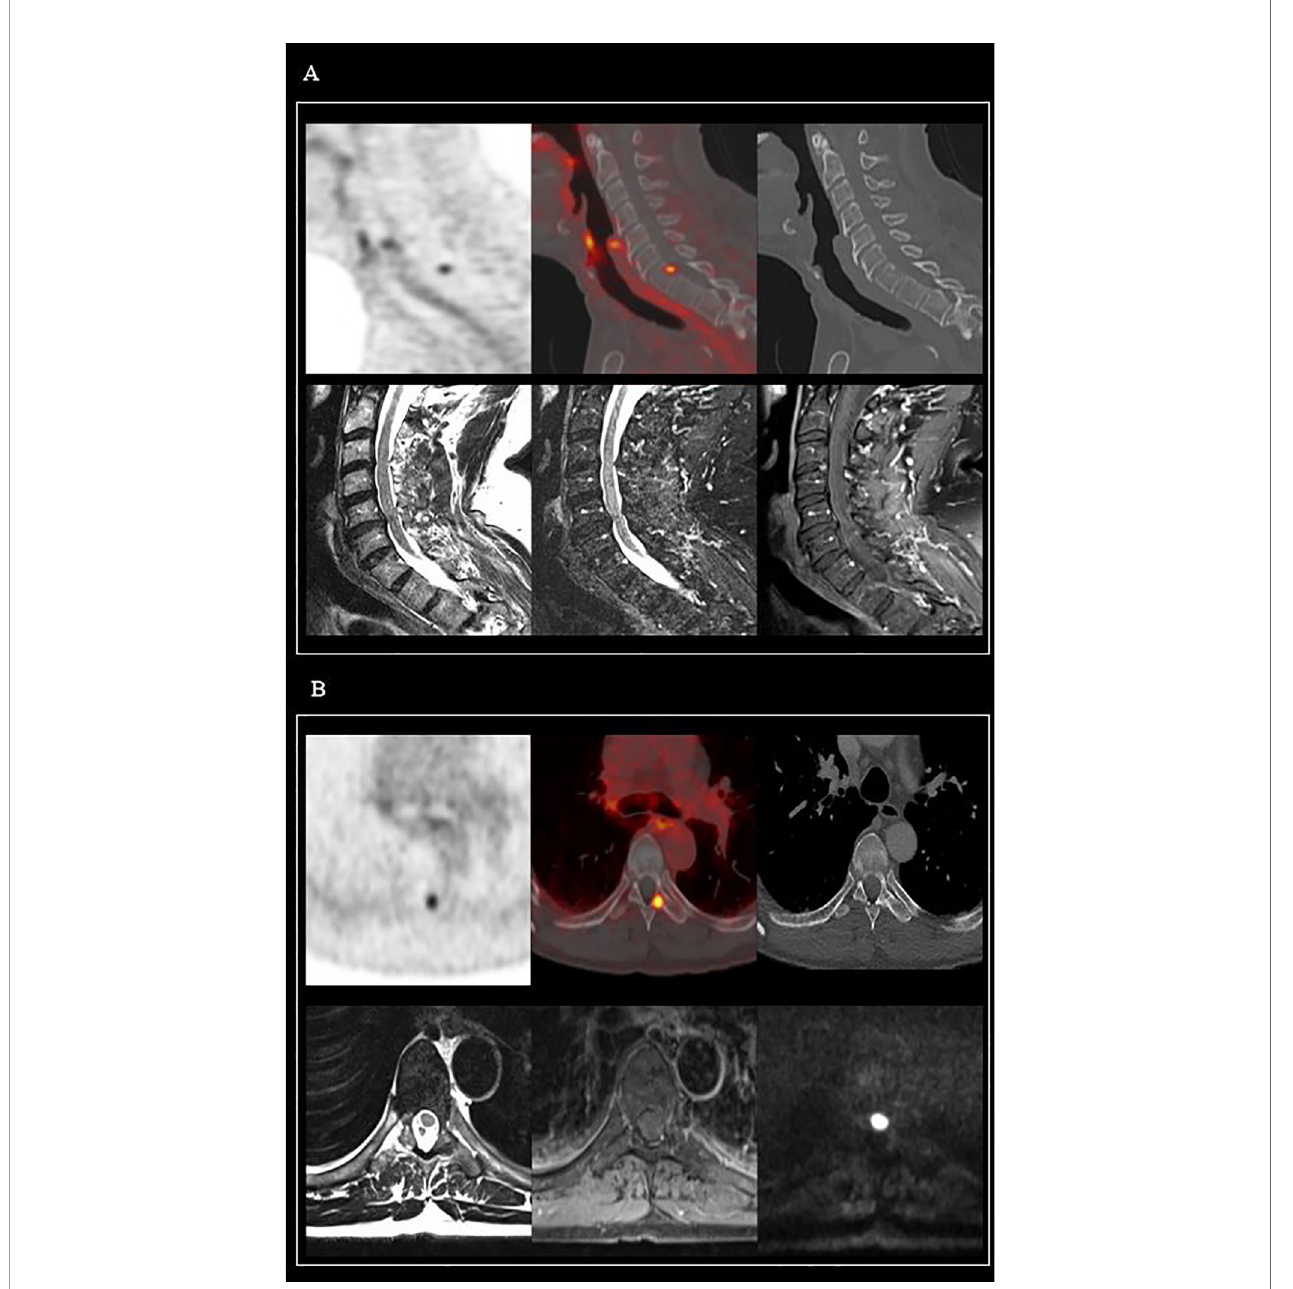
FIGURE 2 | Two cases of PSMA-avid bone uptakes, with no evidence of metastatic lesions on MRI imaging. (A) 68 Ga-PSMA PET/CT: Millimetric and PSMA-avid bone lesion on the posterior part of the vertebral body of C7. MRI (from left to right): T2 TSE, T2, and T1 TSE FS Gadolinium MRI sequences, all in favor of a benign bone lesion. (B) 68 Ga-PSMA PET/CT: Avid bone lesion at the base of the left transverse process of the D7 vertebra. MRI (from left to right): T2 TSE, T1 TSE FS Gadolinium, and b800 diffusion MRI sequences, all in favor of a benign bone